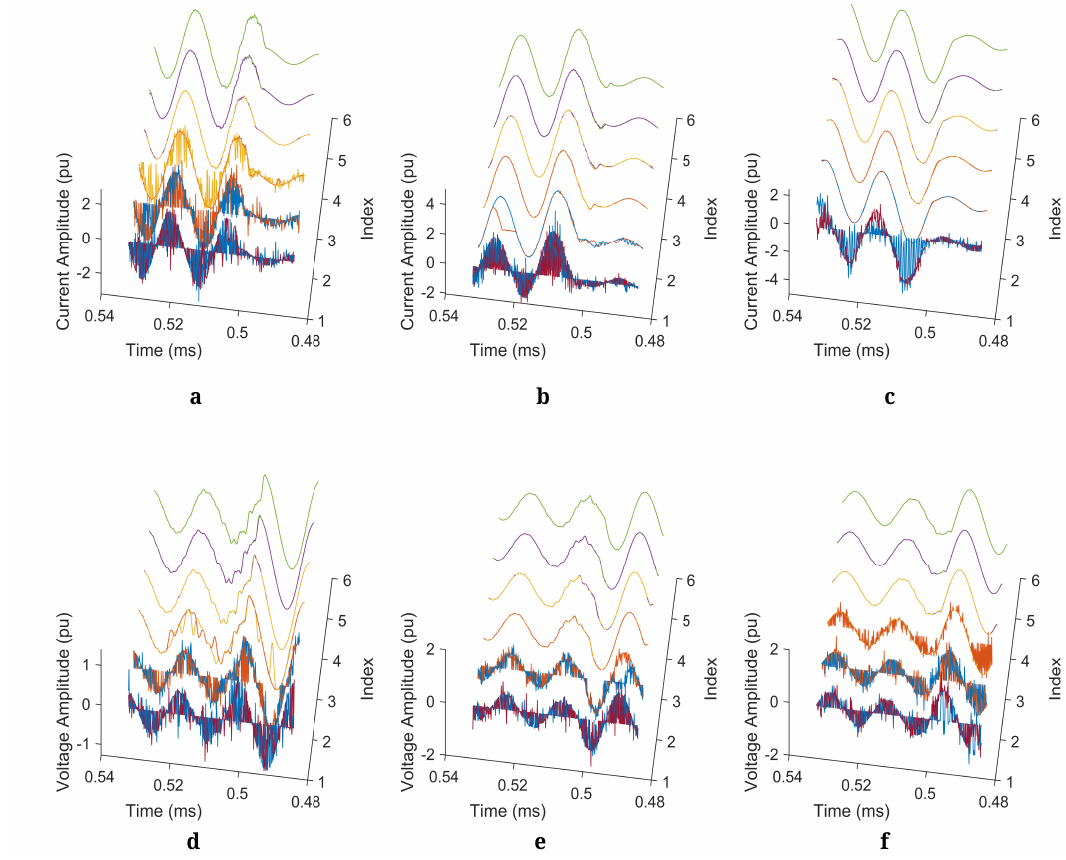
Figure 10. Signal reconstruction using k and m values vs. processing time (( a – c ) current and ( d – f ) voltage at bus